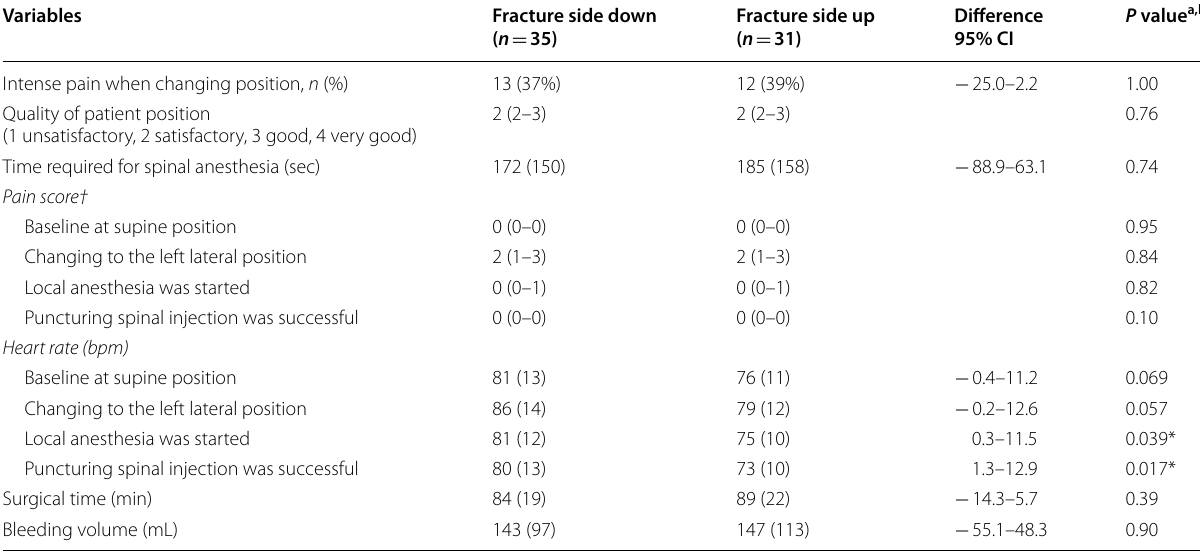
Table 2 Anesthesia/surgical